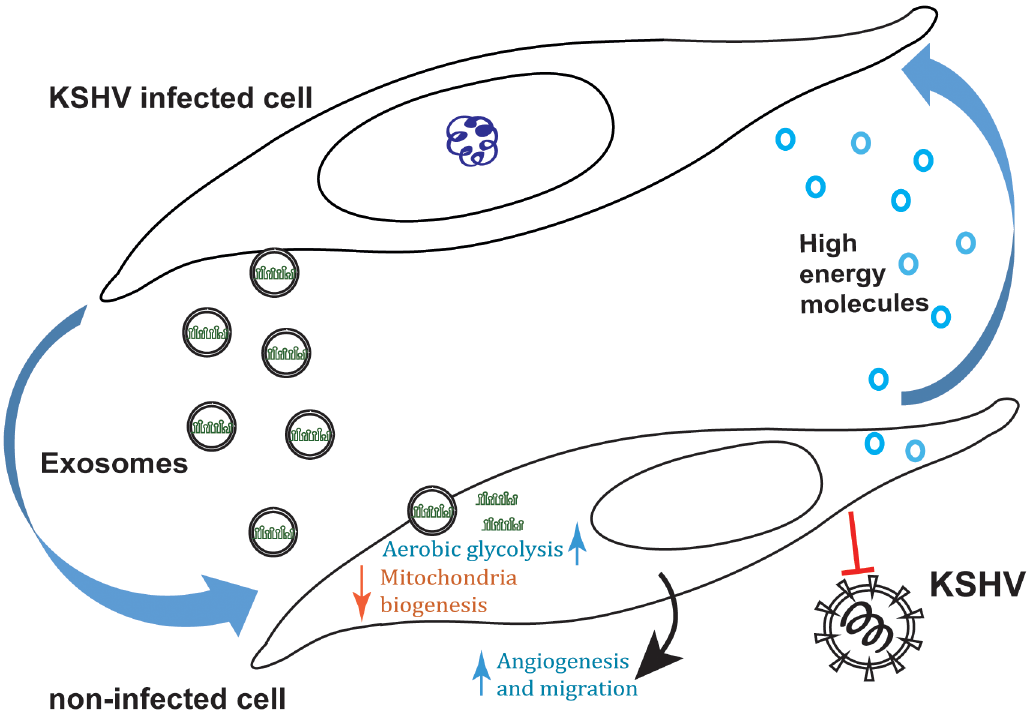
Fig 7. KSHV recruits its microenvironment by transferring its miRNAs in exosomes. Exosomes secreted from latently infected primary LEC transfer the viral miRNAs into neighbouring cells. While these cells remain uninfected, the viral miRNAs are active in them and down regulateexpressionof their target genes. This results in a metabolicshift toward aerobicglycolysis and to reducedmitochondria biogenesis. This process decreases the sensitivity of the exosome-recipient cells to KSHV but increase their angiogenicpotentialand supports replicationin the parental cells by supplyinghigh energy molecules.